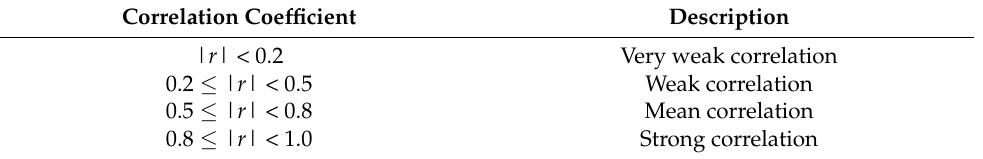
Table 3. Classification of the correlation coefficient r according to Pearson [71].